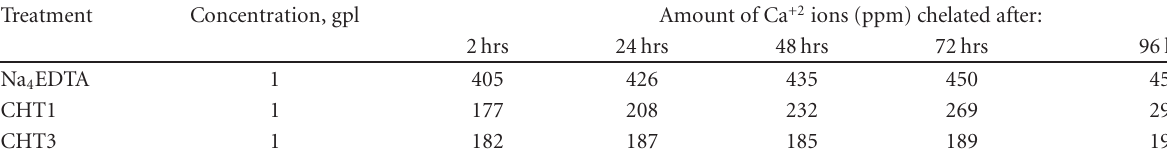
Initial concentration of Ca +2 in water = 625ppm.